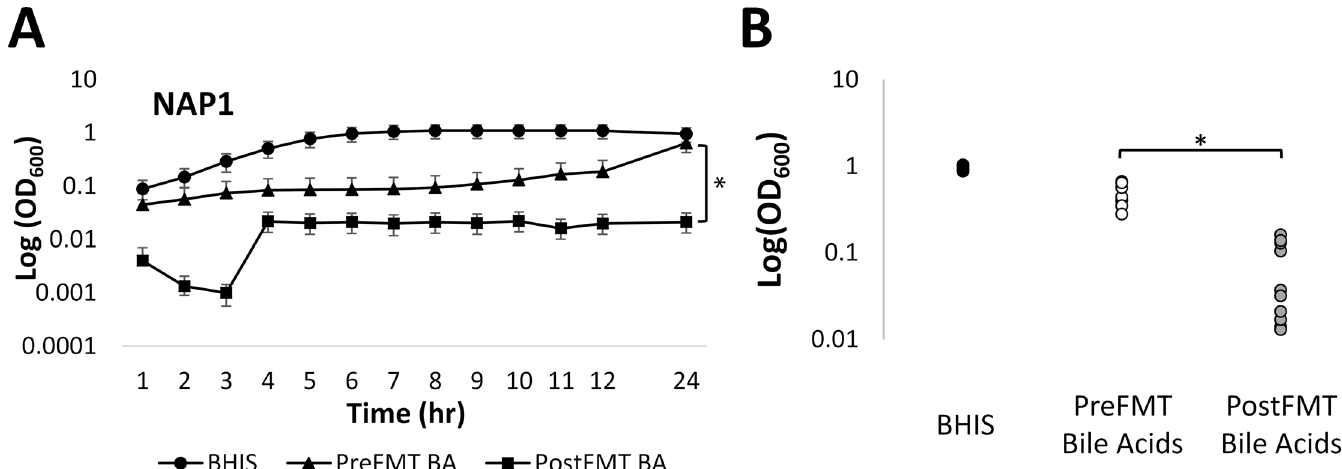
Fig 4. Growth of vegetative C . difficile is inhibited by post-FMT bile acids. A) Hourly OD 600 measurements for NAP1 cells in BHIS alone (circle), BHIS with pre-FMT bile acids (triangle), and BHIS with post-FMT bile acids (square). B) OD 600 at 24 h for 10 isolates. Legend: BA = bile acids; and * = p < 0.01. Data represent mean ±